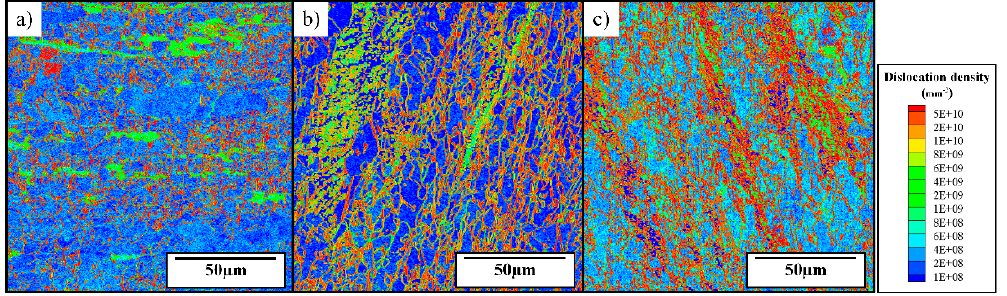
Figure 11. Distribution of GNDs (geometrically necessary dislocations) inside chips with the cutting speeds of ( a ) 750m/min, ( b ) 1500m/min and ( c ) 2250m/min.